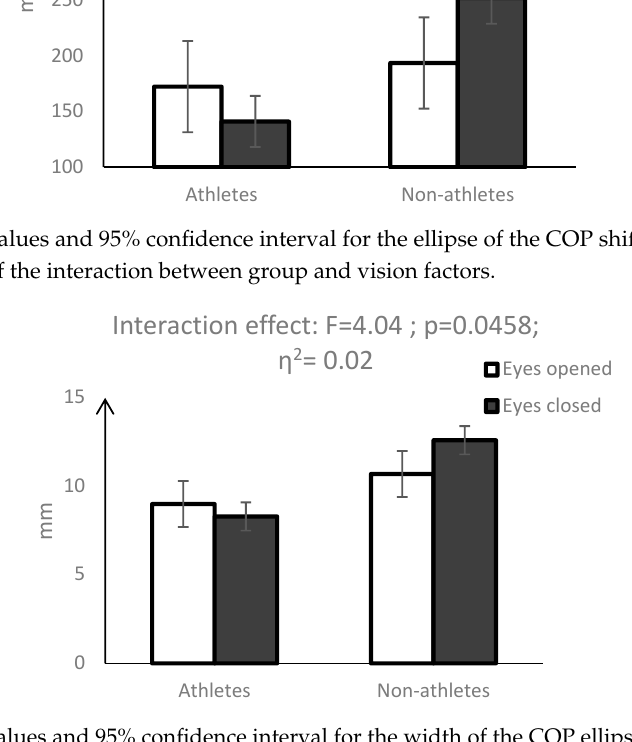
Figure 3. Mean values and 95% confidence interval for the height of the COP ellipse (HoE), along with the results of the interaction between group and vision factors.